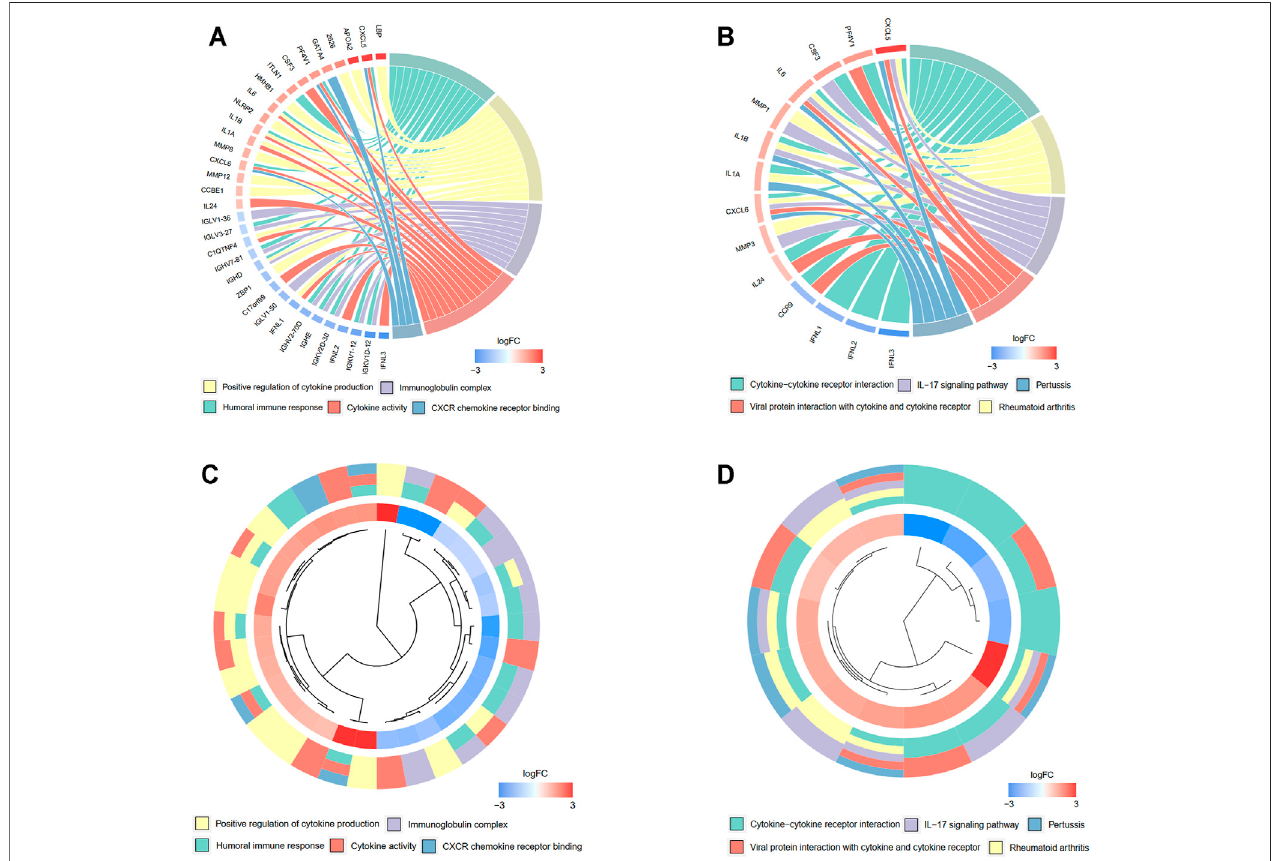
FIGURE7| Functionalenrichmentanalysisofdifferentiallyregulatedgenes(DEGs)betweenlow-andhigh-riskgroups. (A,B) Chordplotdemonstratingthelinkage of genes and assigned term by GO (A) and KEGG (B) pathway enrichment analysis. (C, D) Cluster plot of the expression pro fi les. The inner ring shows the color-coded logFC, while the outer ring illustrates the assigned functional terms by GO (C) and KEGG (D) pathway enrichment analysis.